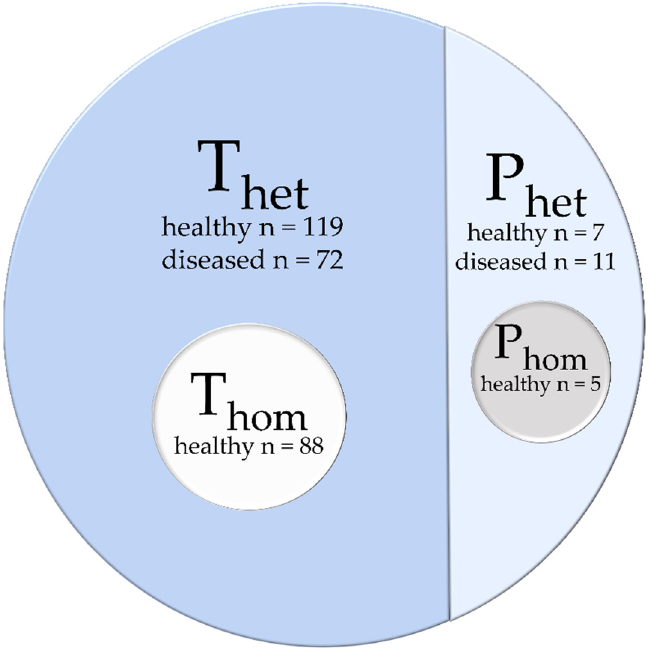
Figure 2. The database is distributed into two main parts: a heterogeneous training dataset T het and a prediction dataset P het . A homogeneous training dataset T hom and prediction dataset P hom are taken as a subset from the heterogeneous datasets.